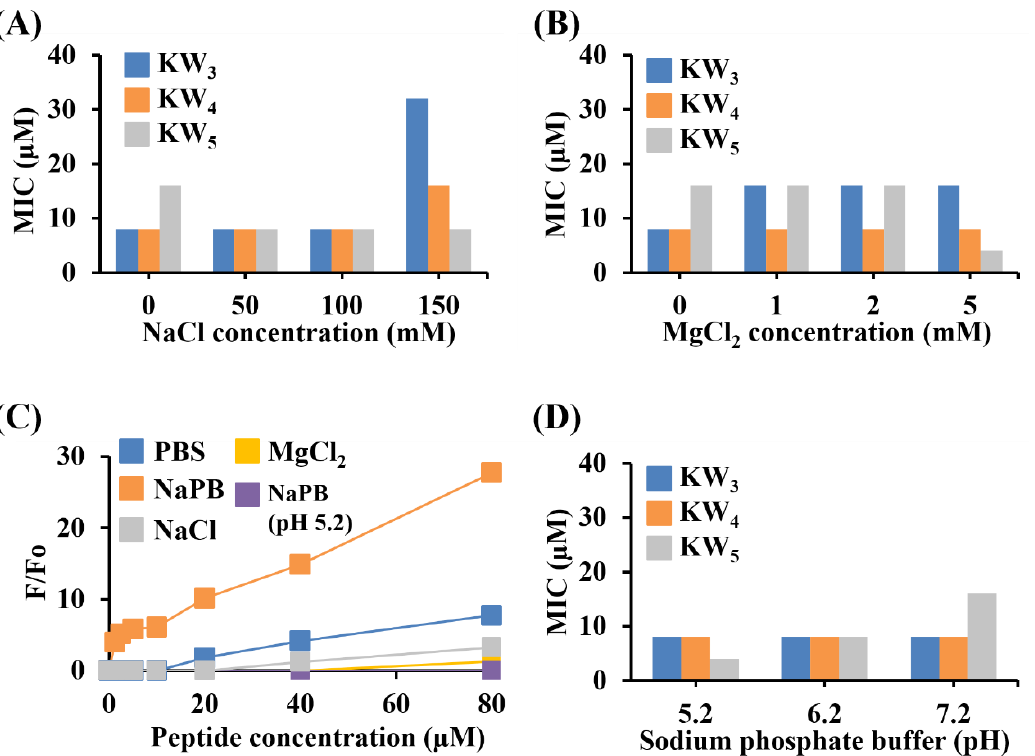
Figure 2. Effect of peptide length, salt and pH on the MICs of the KW n peptides against C. albicans and self-association of the peptide in aqueous solutions. MICs of the peptides against C. albicans in the presence of 10 mm NaPB supplemented with ( A ) NaCl and ( B ) MgCI 2 . ( C ) ThT (20 μM) fluorescence emission intensity measured for KW 5 in different buffer conditions. ( D ) Effect of pH on the antifungal activity of the KW n peptides. An average of all values was obtained from three experiments in duplicate. The data of all test samples were obtained from three replicates, and error bars represent the SD. Data points without error bars indicate that the SD is small and not visible.